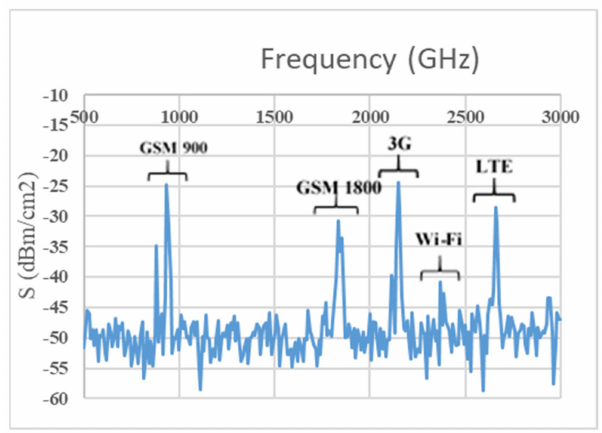
Figure 3. Measurements of available frequency bands and associated RF power